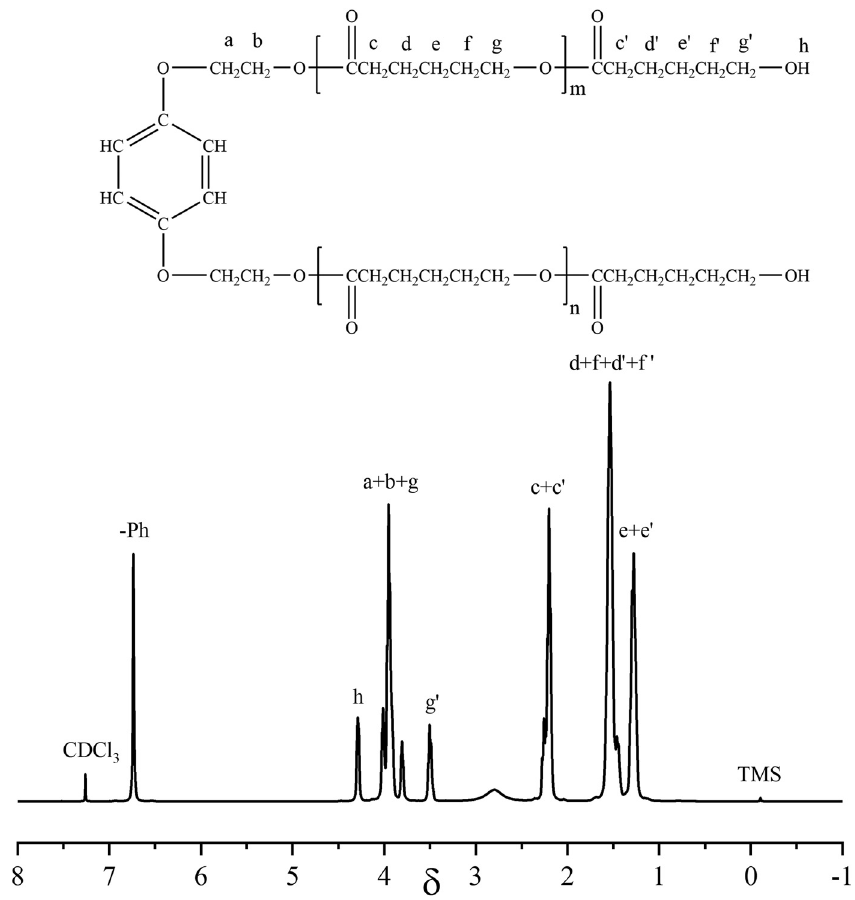
Figure 8: 1 H - NMR spectrum of PCL